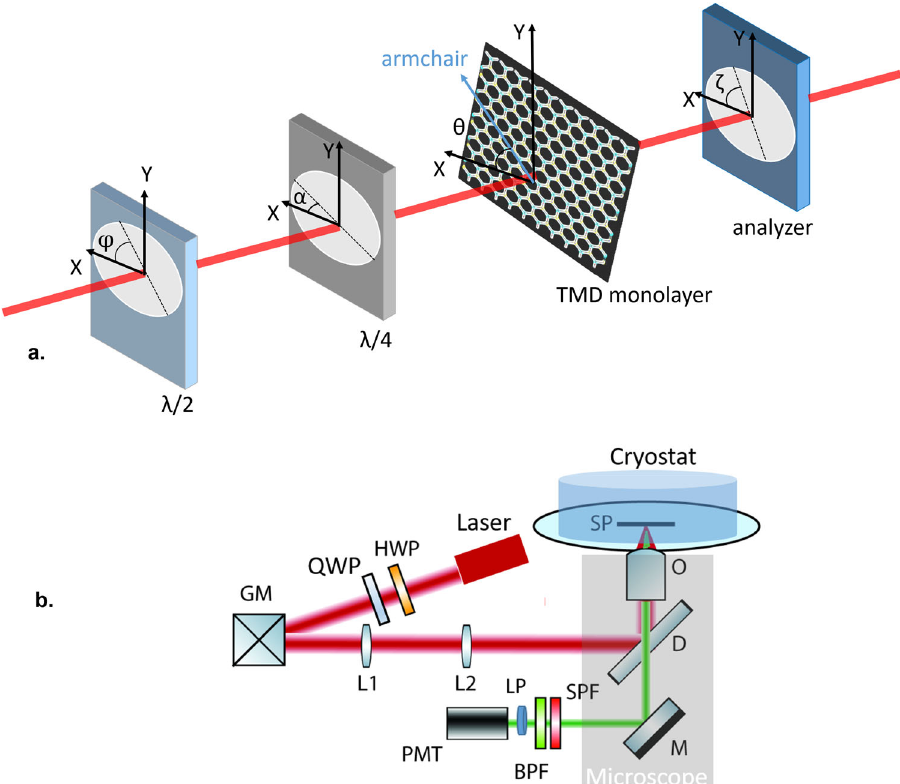
Fig. 2 Experimental con fi guration and setup. a Cartoon of the experimental con fi guration. The de fi nition of the angles φ , α , θ , and ζ is shown, in terms of the laboratory coordinate system ( X , Y black axes) and the fast axes (dashed lines) of the optical elements. b Sketch of the experimental setup. An infrared fs laser excites a 2D TMD held inside the cryostat. The SHG signal emerging from the sample is directed to the detector in re fl ection geometry. HWP half-wave plate, QWP quarter-wave plate, GM galvanometric mirrors, L1, L2 lenses, D dichroic mirror, O objective lens, SP sample plane, M mirror, SPF short-pass fi lter, BPF bandpass fi lter, LP linear polarizer, PMT photomultiplier